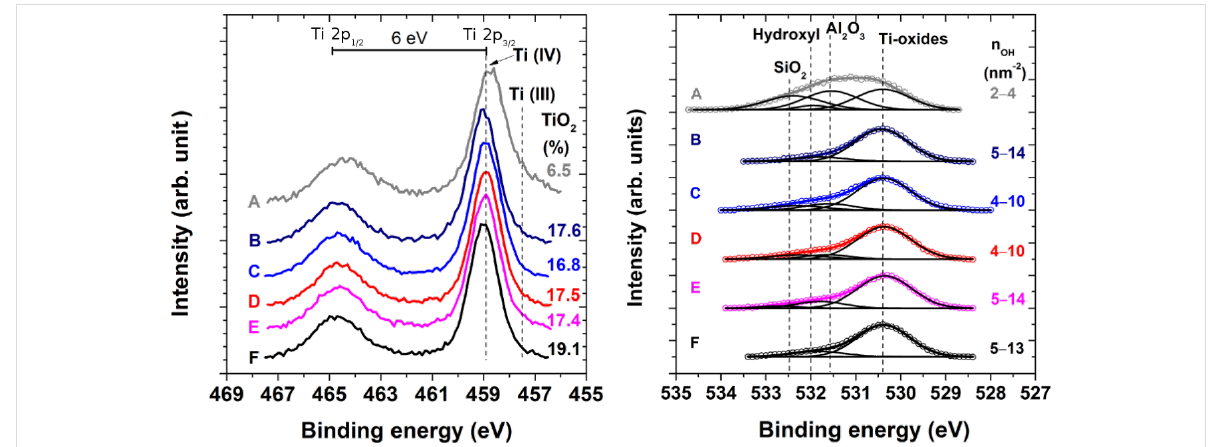
Figure 1: High resolution Ti 2p (left) and O 1s (right) XPS spectra of pristine titanium surfaces (A) and surfaces treated using alkaline piranha (B), 0.5 M NaOH (C), a HCl/H 2 SO 4 mixture (D) and piranha solution (H 2 SO 4 /H 2 O 2 ) (E). The spectrum of flat titanium surfaces deposited on silicon substrates (F) is given for comparison. The dominant contribution (more than 96.7%) within the Ti 2p 3/2 envelope appears at 458.9 ± 0.1 eV and is identified as TiO 2. The measured O 1s spectra (points) was fitted (solid, colored lines) by resolving the individual surface oxide contributions (black lines) centered at 530.3 ± 0.1, 531.5 ± 0.1 and 533.0 ± 0.3 eV arising from titanium oxides (TiO 2 and Ti 2 O 3 ), Al 2 O 3 and SiO 2 , respectively. The hydroxy groups on the surface gave rise to the peak at 531.8 ± 0.2 eV. The figure also reports the surface density of hydroxy groups (n OH